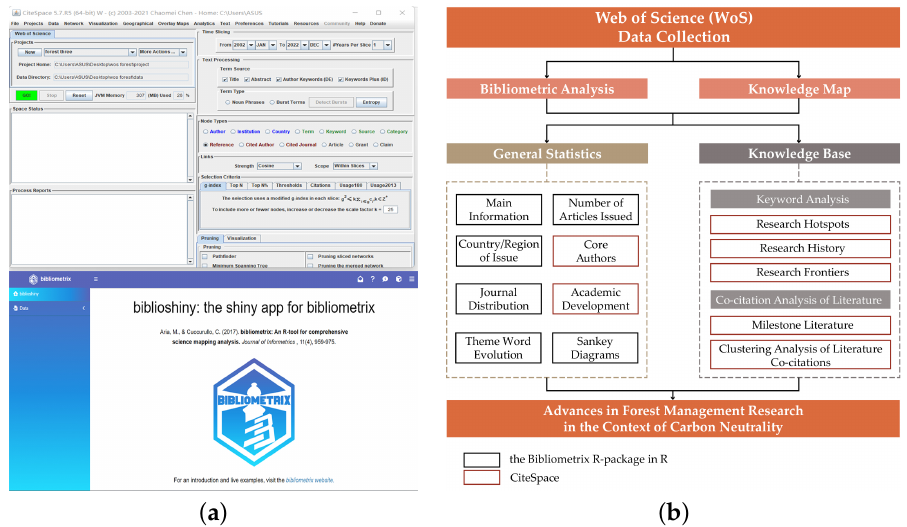
Figure 1. The main operating interface of CiteSpace 5.7.R5 (top) and the bibliometrix R-package in R (bottom). These two interfaces are the first pages that appear after opening the software. All subsequent analyses are carried out from these interfaces.the analytical approach ( a ) and analysis process ( b ) of this